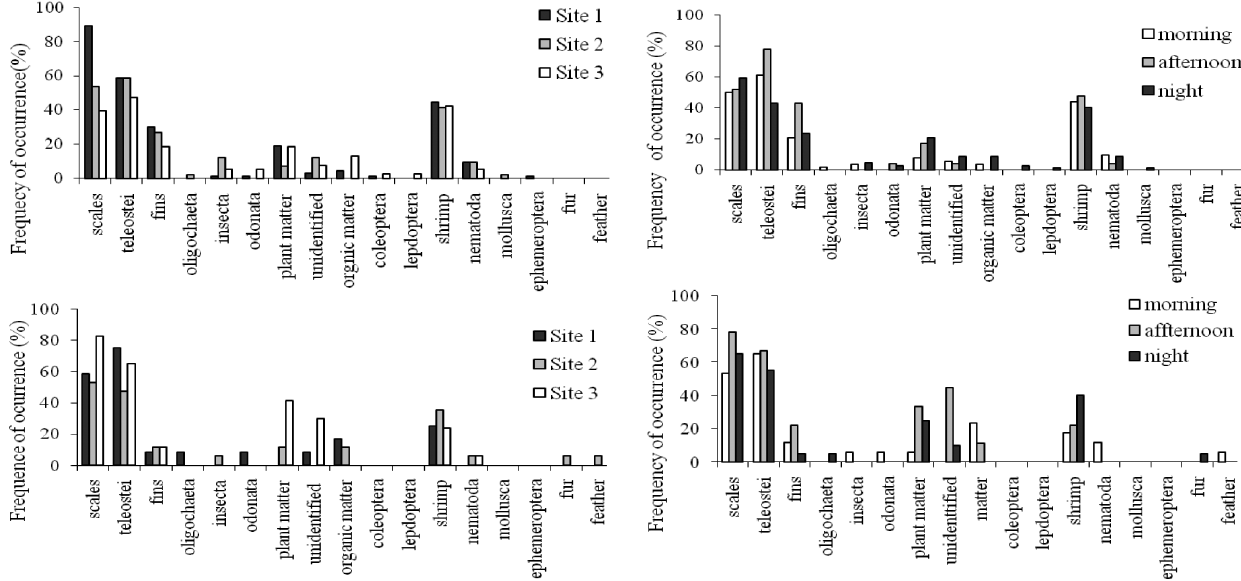
Fig. 4. Frequency of occurrence (%) of different food items determined by the analysis of the stomach content of Ser- rasalmus brandtii (a) and Pygocentrus piraya (b) collected between May 2001 and April 2003 according to the three daily sampling periods.